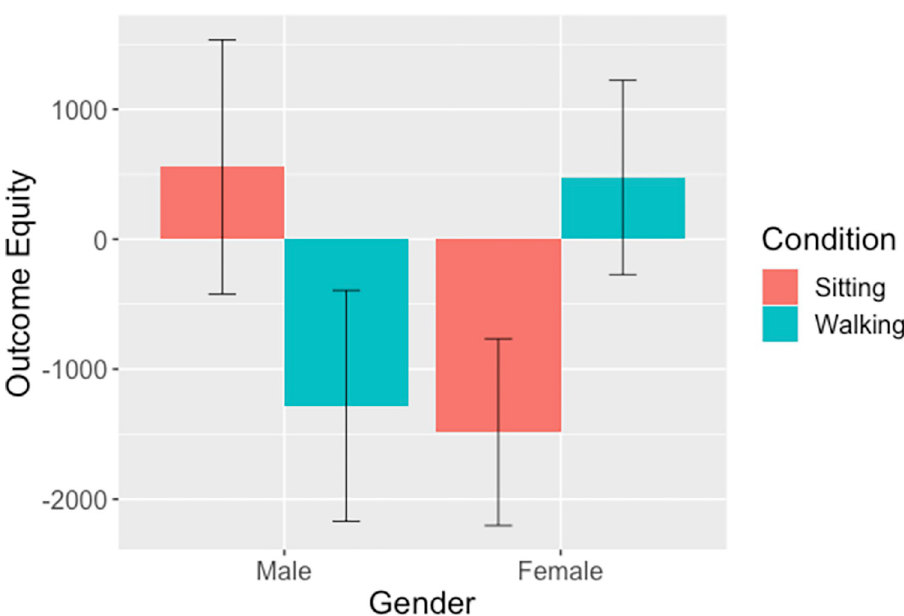
Fig 2. Outcome Equity x Condition x Gender. Note : Error bars reflect standard errors of the mean. Closer to zero, or lower values of the differences, indicates more equal distribution of points within the pair.